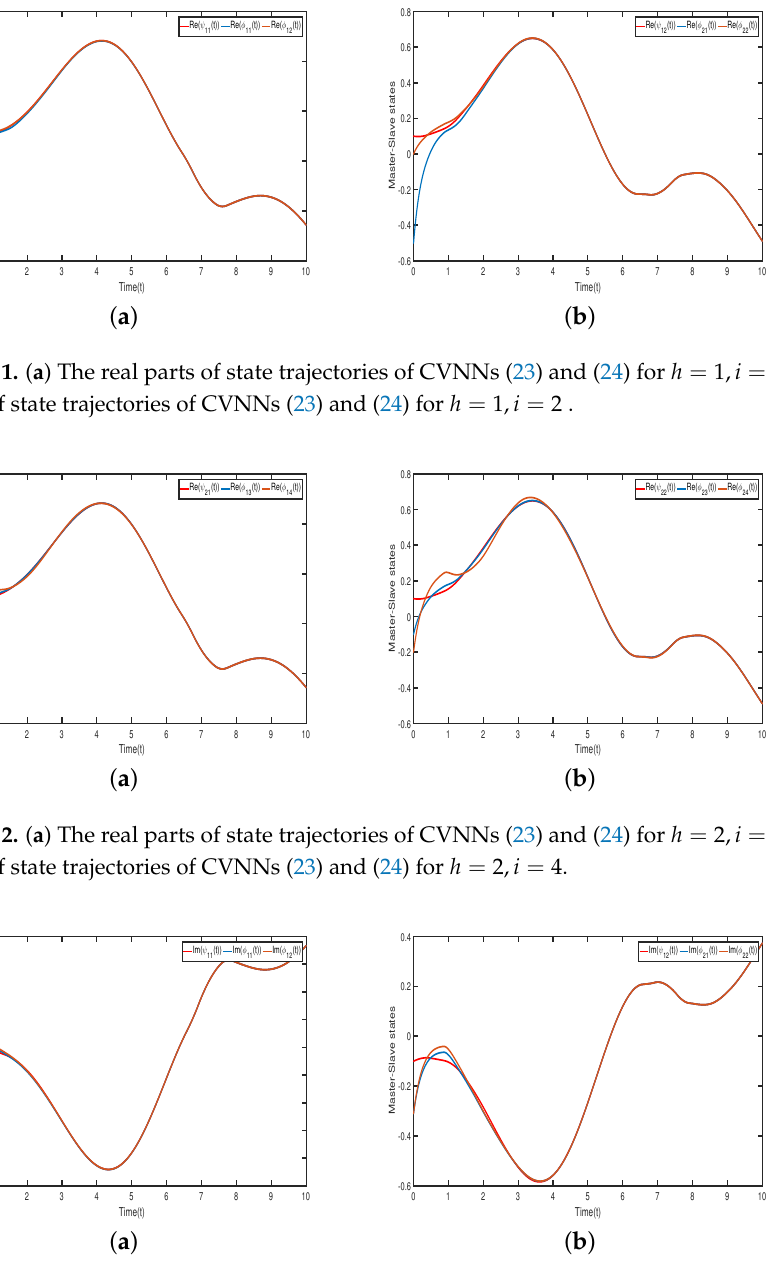
Figure 3. ( a ) The imaginary parts of state trajectories of CVNNs (23) and (24) for h = 1, i = 1. ( b ) The imaginary parts of state trajectories of CVNNs (23) and (24) for h = 1, i =